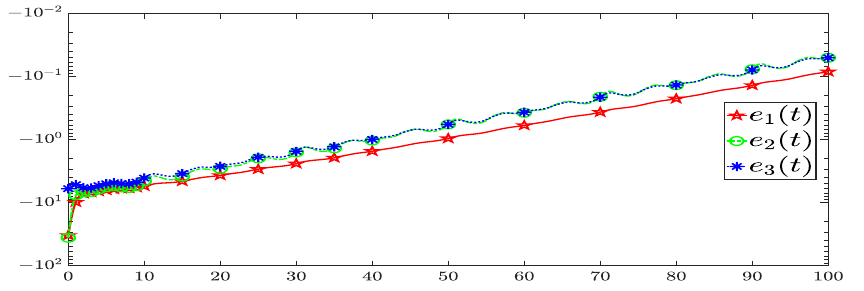
Figure 3. The corresponding error trajectories of system (1).